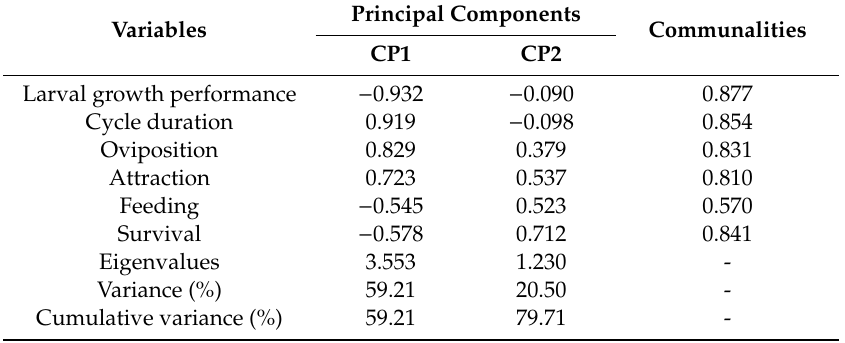
Table 5. Component loadings matrix for trap plants selection variables for S. frugiperda